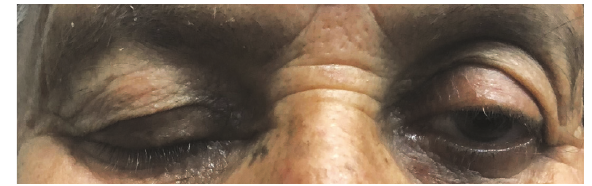
Figure 4: Photograph showing the right sided ptosis due to oculomotor nerve palsy.